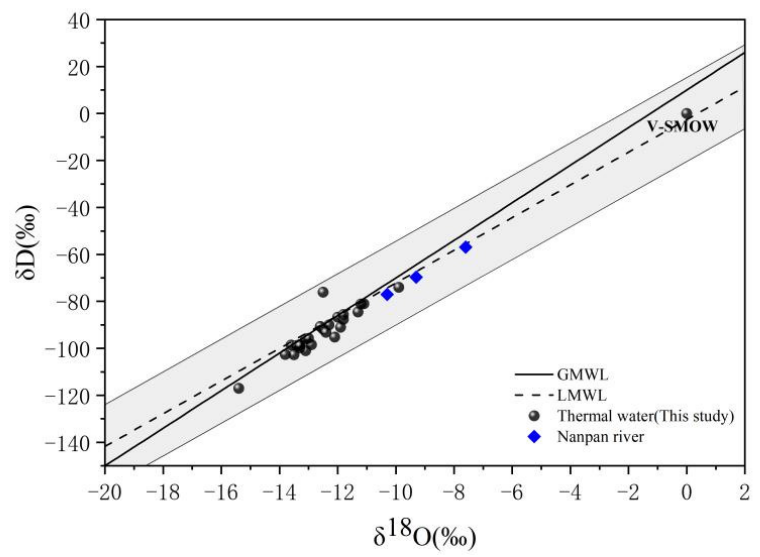
Figure 2. Plot of δ D versus δ 18 O for the hot springs and stream waters.( The Global Meteoric Water Line (GMWL) from Craig (1961). The local meteoric water line (LMWL) [48] is shown for reference with the prediction interval (shaded area; δ D = ±17.88‰) [53]).